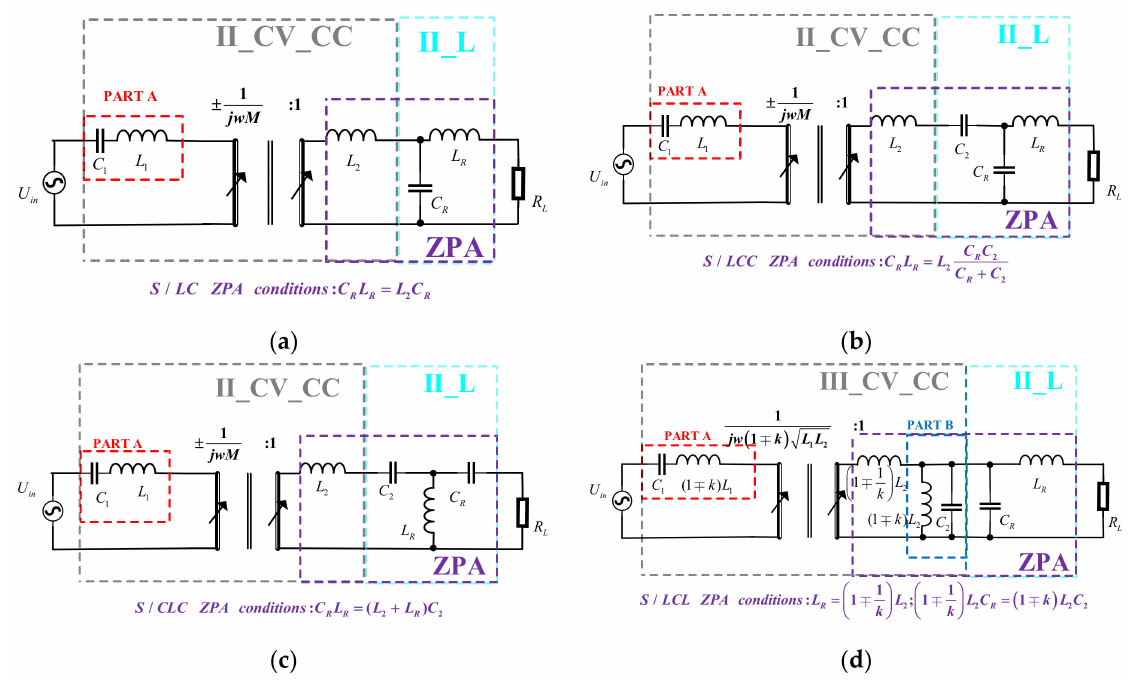
Figure 29. The CV_CC_L compensation topologies: ( a ) S/LC; ( b ) S/LCC; ( c ) S/CLC [12]; and ( d ) S/LCL [33]. Table 4. The design results for voltage-fed compensation circuit with load-independent CV output at ZPA frequencies.